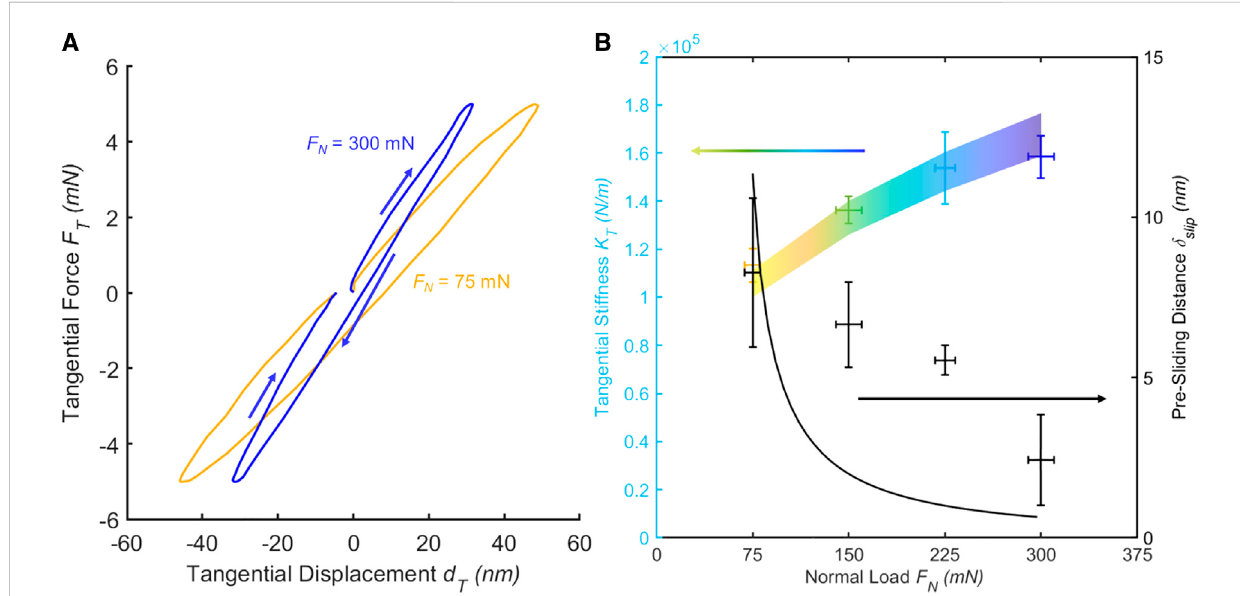
FIGURE 2 (A) Pre-sliding hysteresis curve measured at a 3-PTFE-balls/Si interface at 75 mN and at 300 mN collective normal load. (B) Tangential stiffness and pre-slidingdistanceofthe3-PTFE-balls/Siinterfaceatdifferentnormalloads.Datapointsrepresentexperimentswhilethecoloredareasrepresenttheory predictions from Eq. 1and Eq. 2using the parameters and their uncertainty provided inthe Materials and Methodssection. Forthe friction coef fi cient, we used μ = 0.07. The error bars indicate the standard deviation obtained from fi ve independent pre-sliding experiments, each conducted on different PTFE and Si